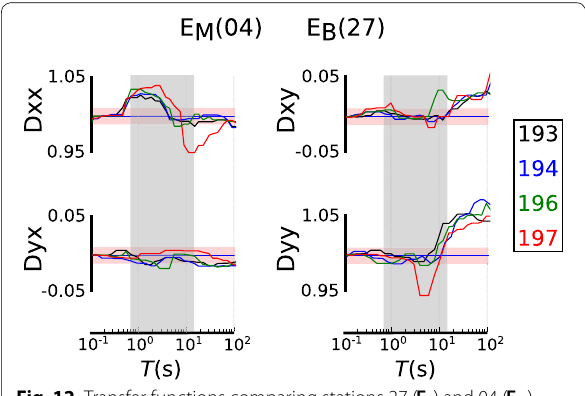
Fig. 12 Transfer functions comparing stations 27 ( E B ) and 04 ( E M